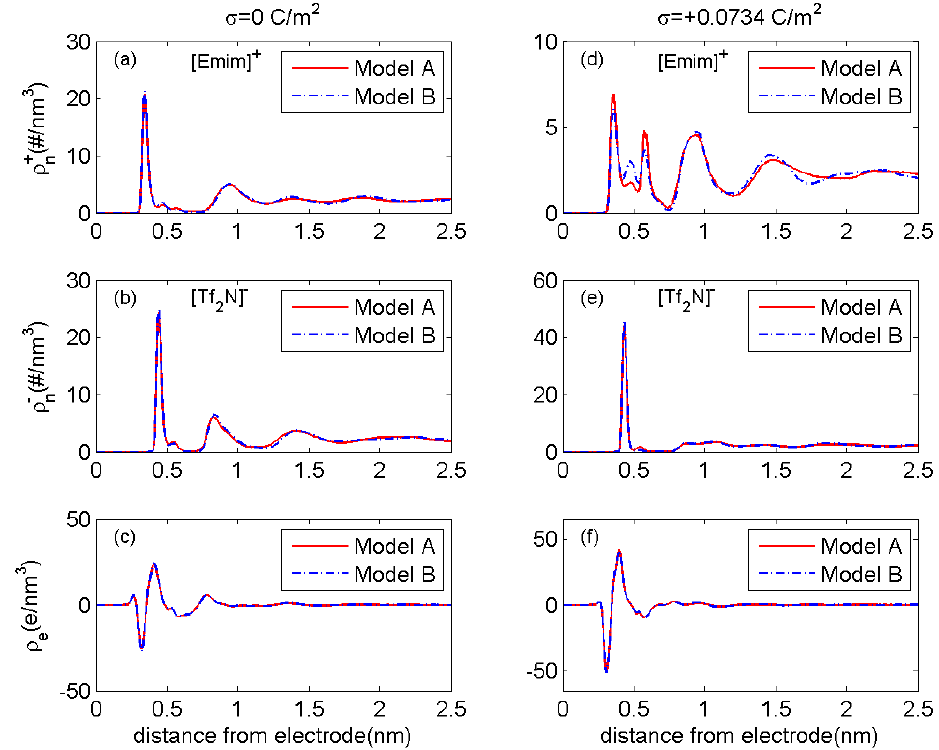
Figure 1. Ion number density and charge density profiles at 350 K. Number density of [Emim] + near neutral ( a ) and electrified ( d ), electrodes with surface charge density σ = 0.0734 C/m 2 ). Number density of [Tf 2 N] − near neutral ( b ) and electrified ( e ) electrodes. Space charge density near neutral ( c ) and electrified ( f ) electrodes. The location of the cations and anions were computed on the basis of the geometrical center of the imidazolium ring and the entire anion, respectively.